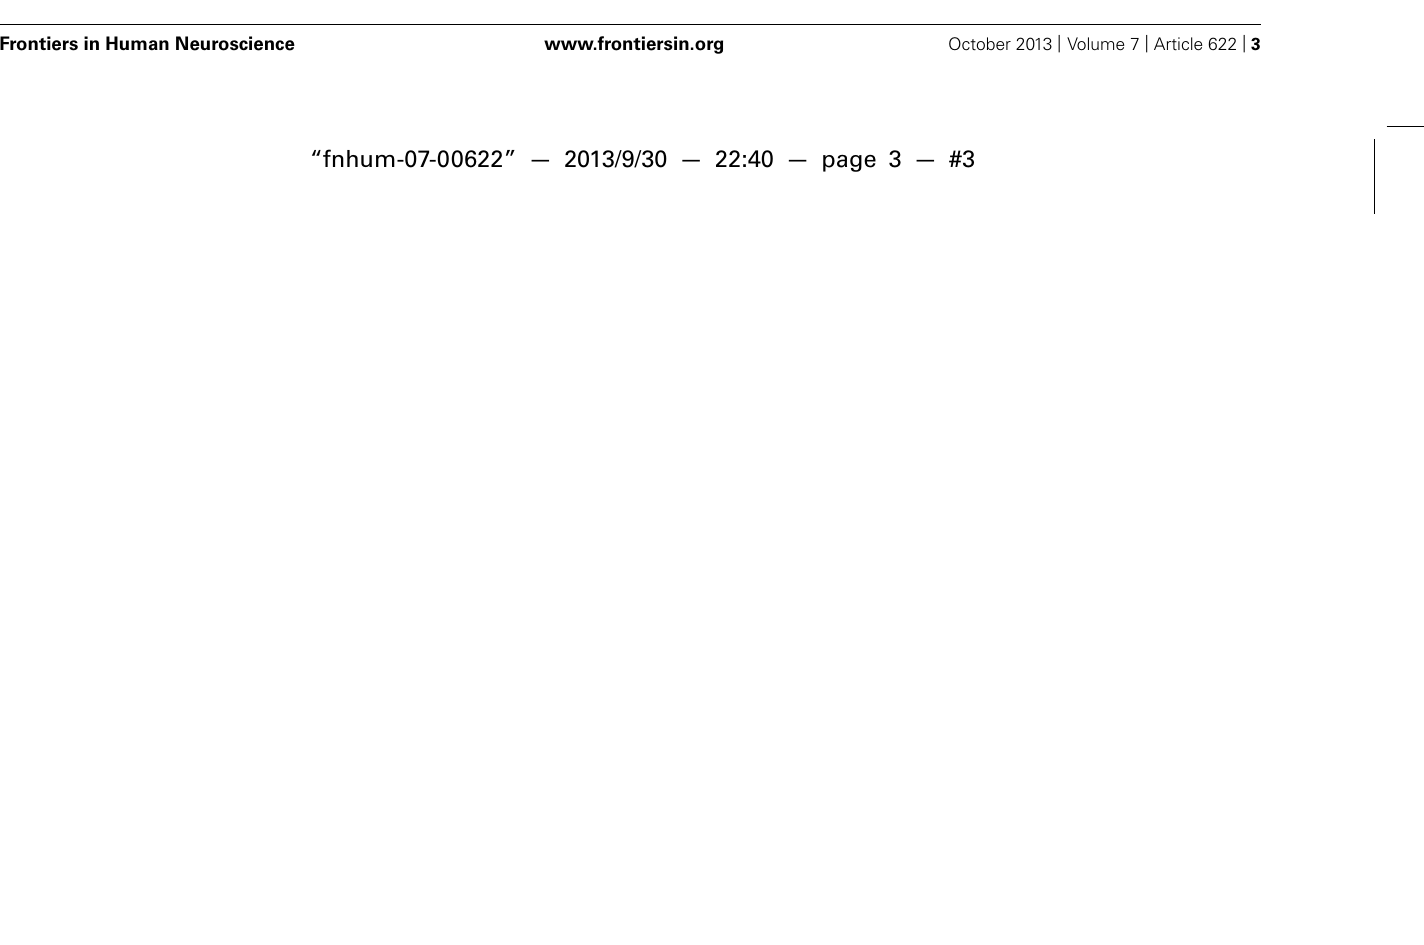
prescribed set of trials (30% of the trials). In case of a